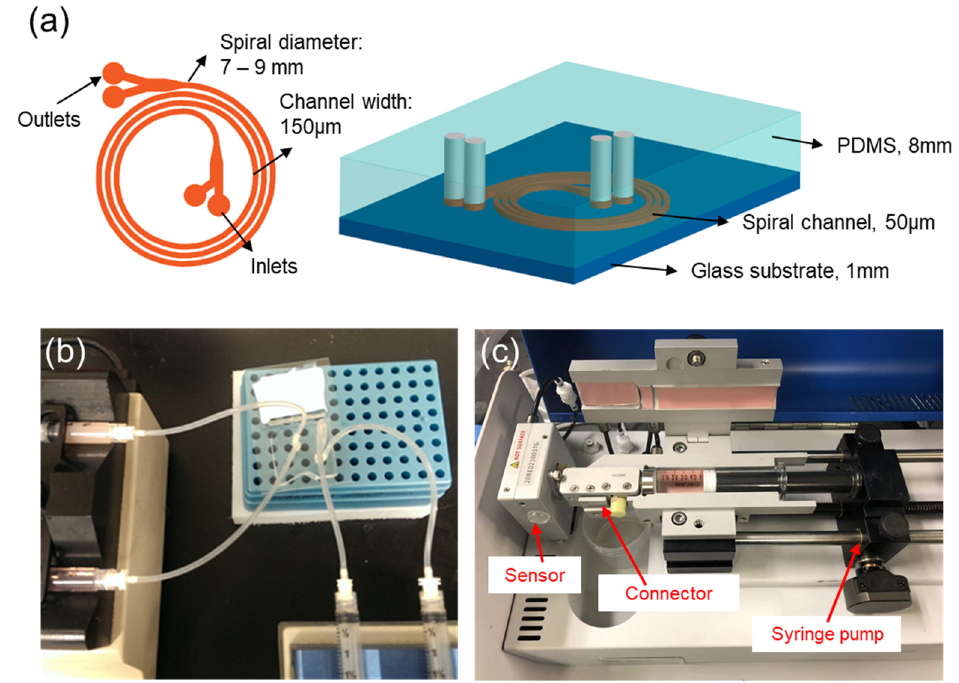
Figure 2. Picture of experimental device set up. ( a ) Schematic view of spiral channel device. ( b ) Microfluidic chip channel connection for particle loading and flow rate control. ( c ) Device structure of m ‐ VROC rheometer.